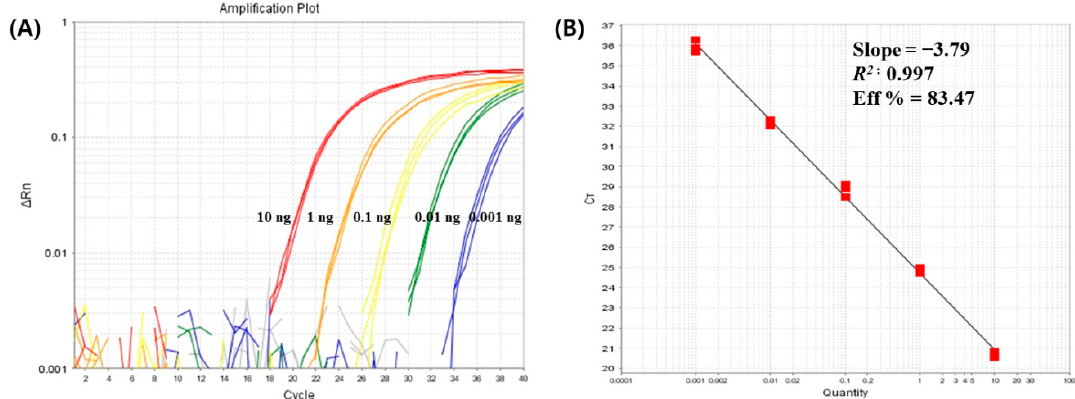
Figure 1. Amplification plot ( A ) and standard curve ( B ) for the detection of donkey DNA using 10-fold serial dilutions (from 10 to 0.001 ng).